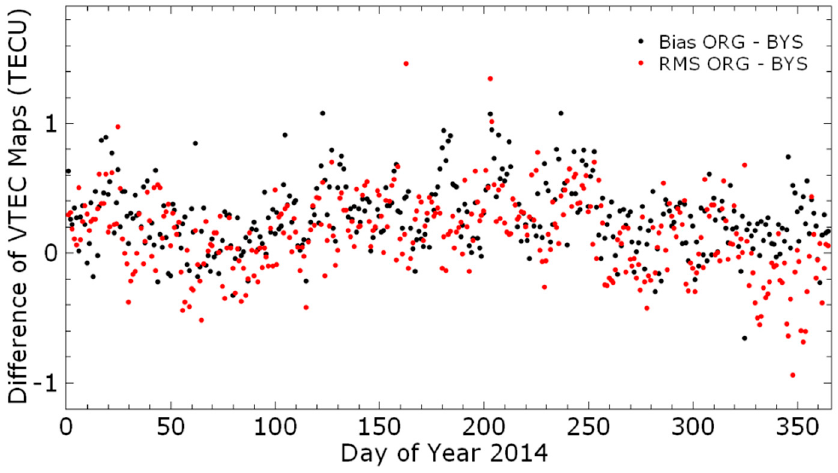
Figure A2. RMS values of differences between IGS GIMs or IAAC products and J2TEC in 2014.